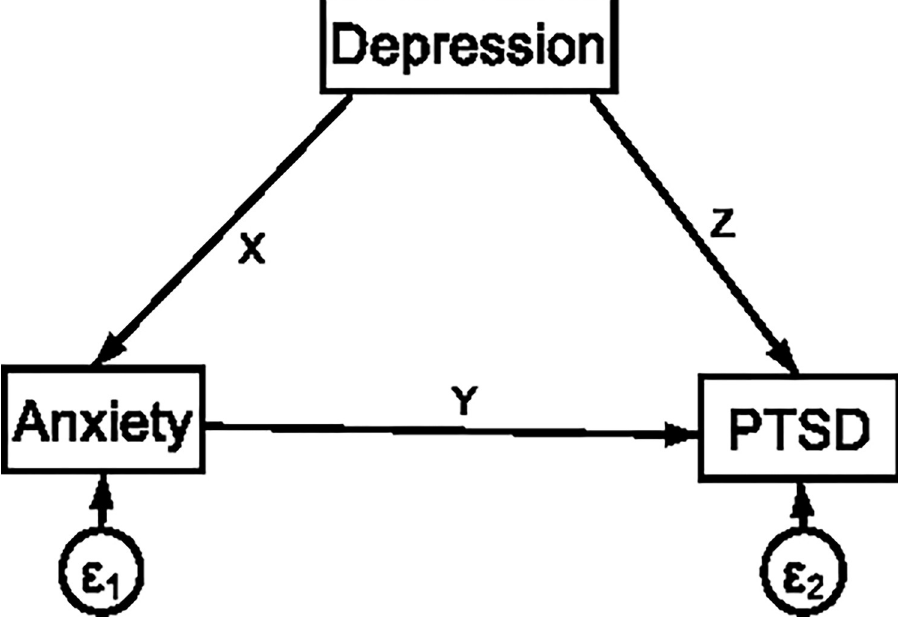
Fig 1. Example of a mediation analysis pathway for the direct and indirect (through anxiety) association of depression with PTSD